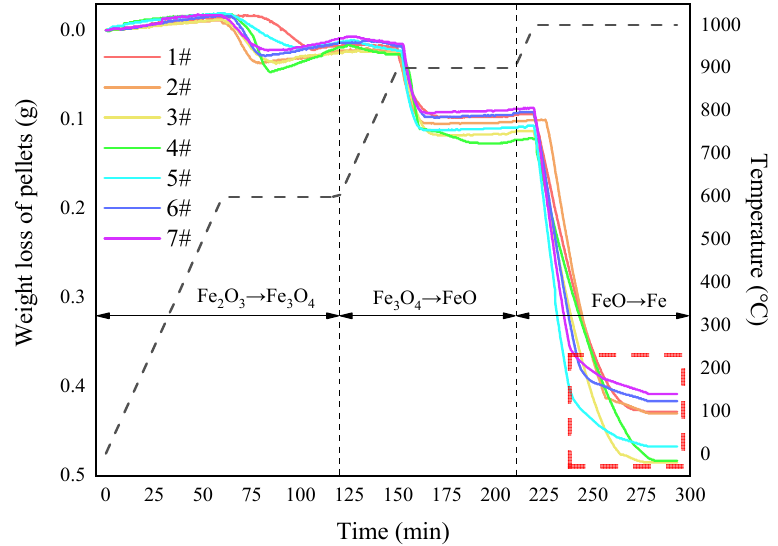
Figure 7. The respective weight of pellet samples with different basicities. Studies have shown [25] that the diffusion of alkali metals into the iron oxide lattice can expand the ion channels of the reactants and reduce the activation energy of the interfacial reduction reaction, thereby speeding up the interfacial reduction reaction. Therefore, by comparing and observing the occurrence state of alkali metals in iron oxides in pellet samples with different basicities, the difference in the weight loss and weight-loss rate of pellets with different basicities can be explained. The analysis of this explanation will be explained in detail in Section